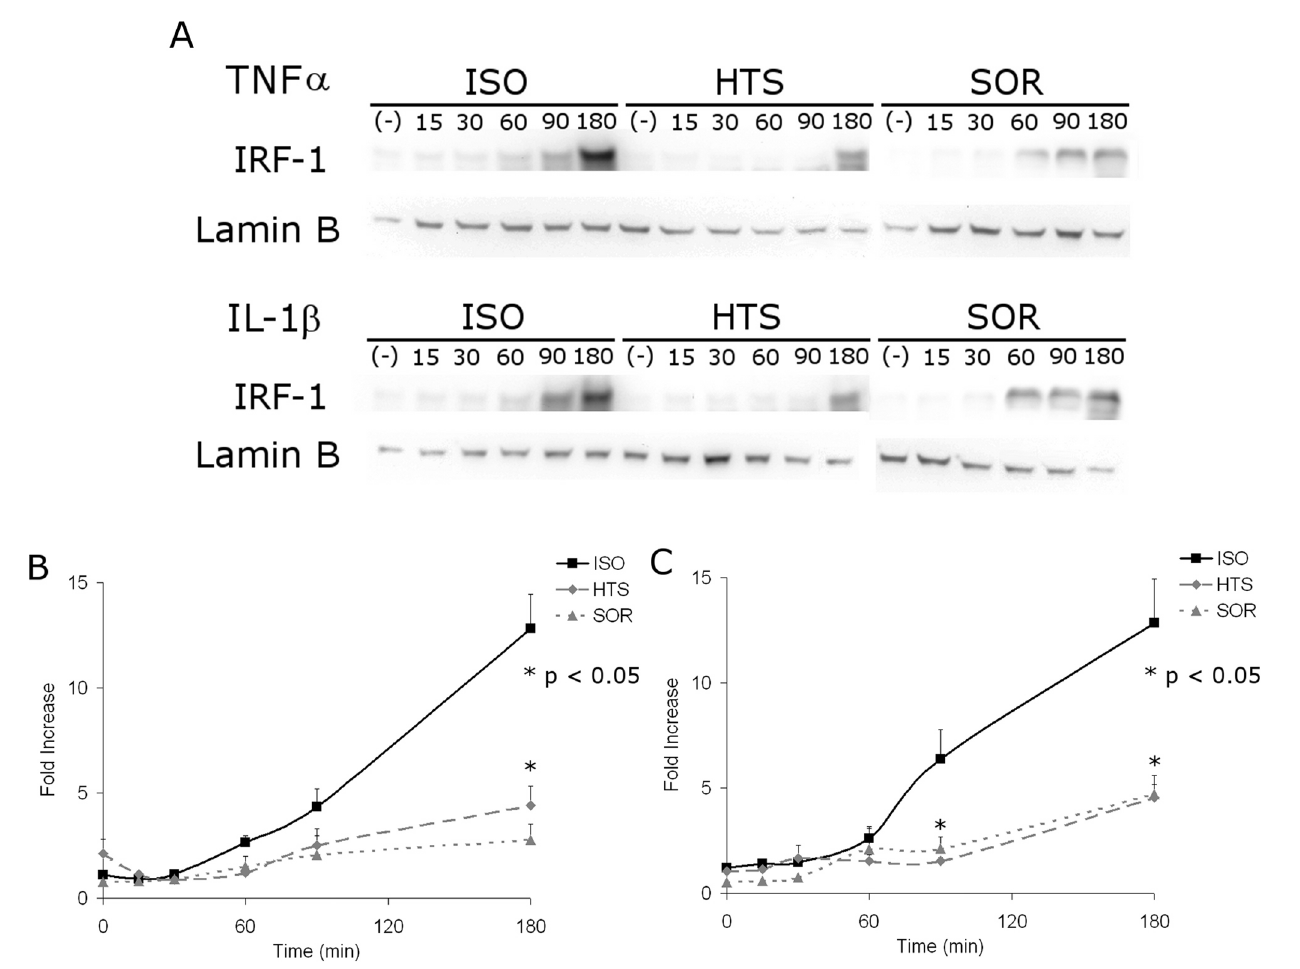
Figure 6. HOsm inhibits IRF-1 localization to the nucleus with either TNF a or IL-1 b stimulation. IRF-1 in the nuclear extract of cells stimulated by TNF a or IL-1 b in the presence of 400 mOsm HTS or sorbitol was examined by immunoblotting (A), figure is representative of three separate experiments. The gels were digitized and quantitated for nuclear IRF-1 after TNF a (A) or IL-1 b stimulation (C); * p , 0.05 for ISO vs. either HTS or SOR at matched time points; no significant differences were found between HTS and SOR